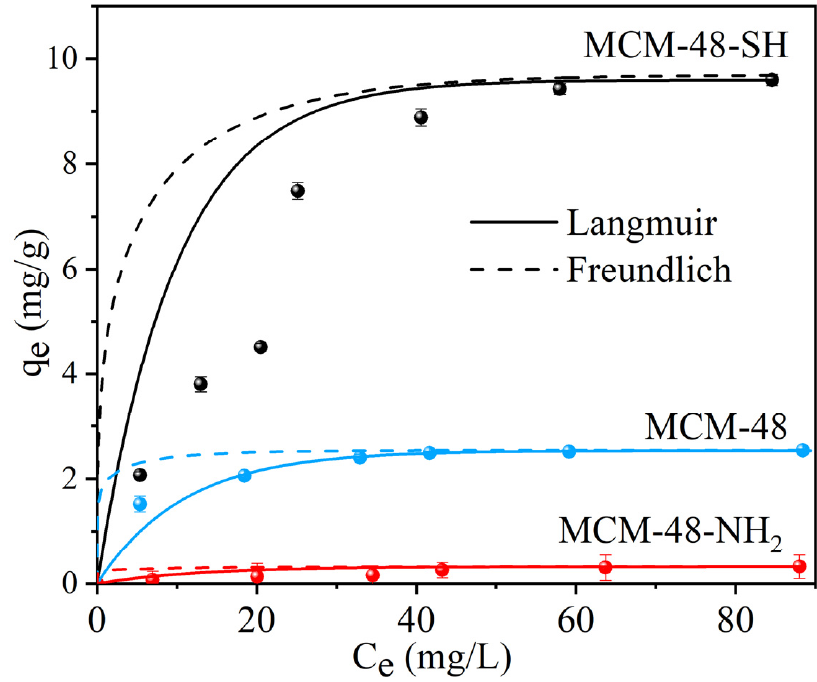
Figure 7. Adsorption isotherm of Cr(VI) adsorption by MCM-48, MCM-48-SH, and MCM-48-NH 2 (the reaction temperature was 25 °C, the amount of adsorbent was 25 mg, the pH of the solution was 2, and the reaction time was 3 d). Table 2. Fitting data of the adsorption isotherm models of MCM-48, MCM-48-SH, and MCM-48-NH 2 .